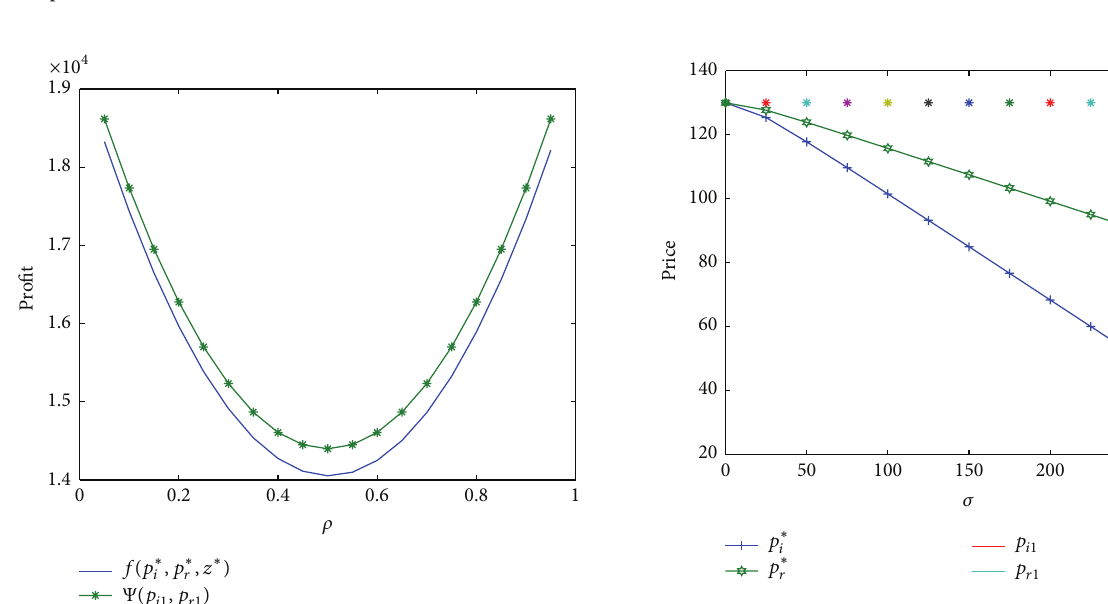
Figure 1: Impact of 𝜌 on the optimal internet price and traditional retail price.